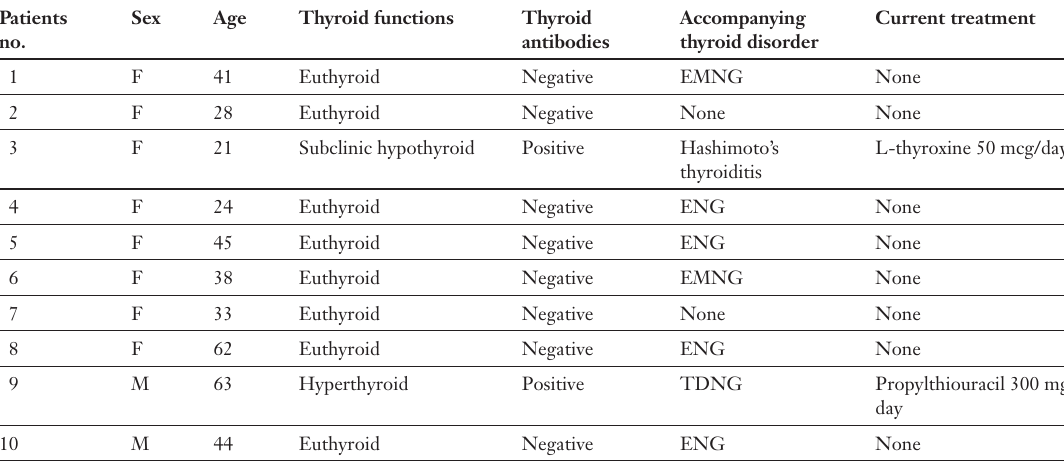
General features of patients with thyroid